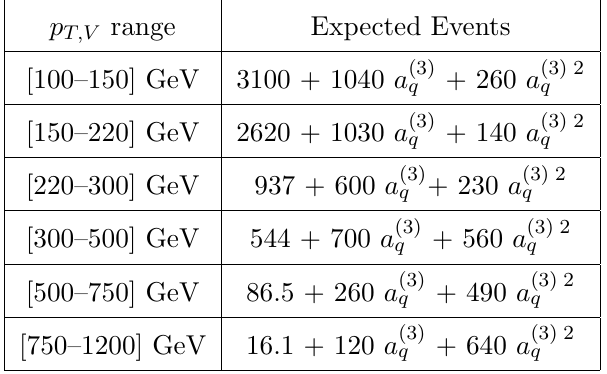
Table 6 . Expected number of events as a function of the HEP a (3) q (expressed in TeV (cid:0) 2 ) in each bin of the p T;V spectrum at LHC 14 TeV for 3/ab integrated